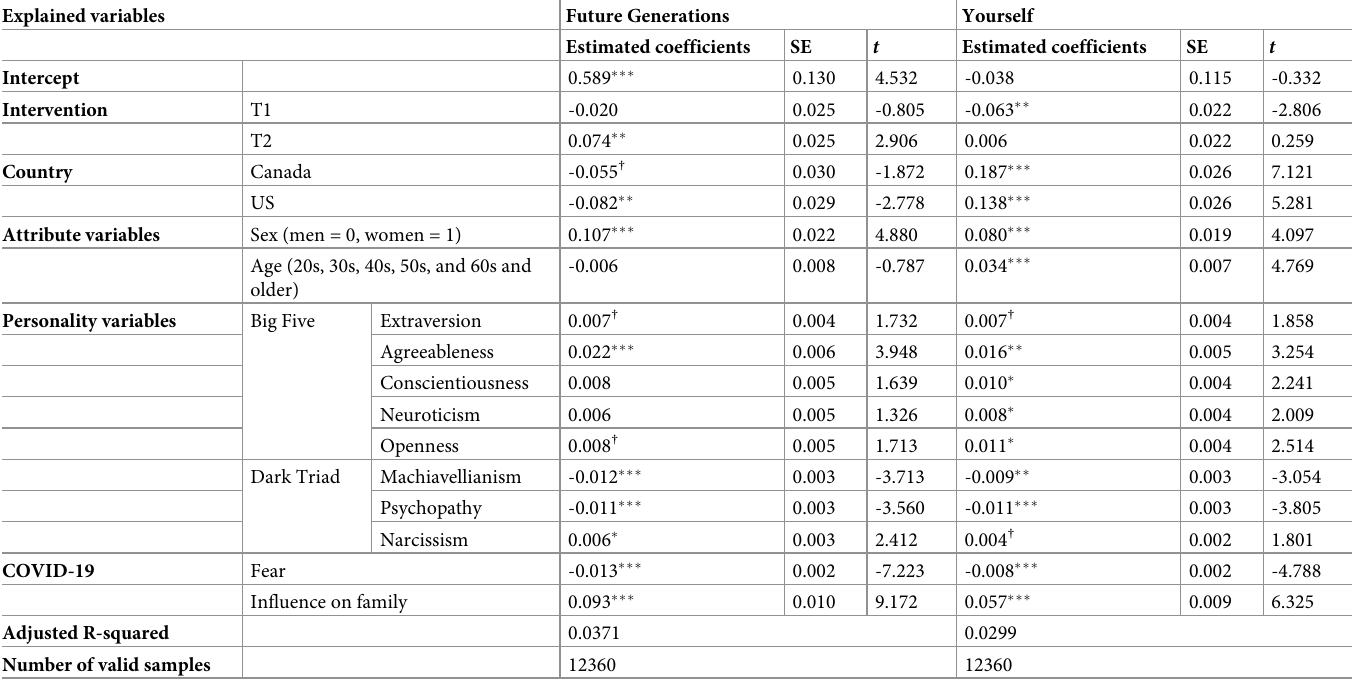
Table 6. Coefficients from linear regression analysis. Explained